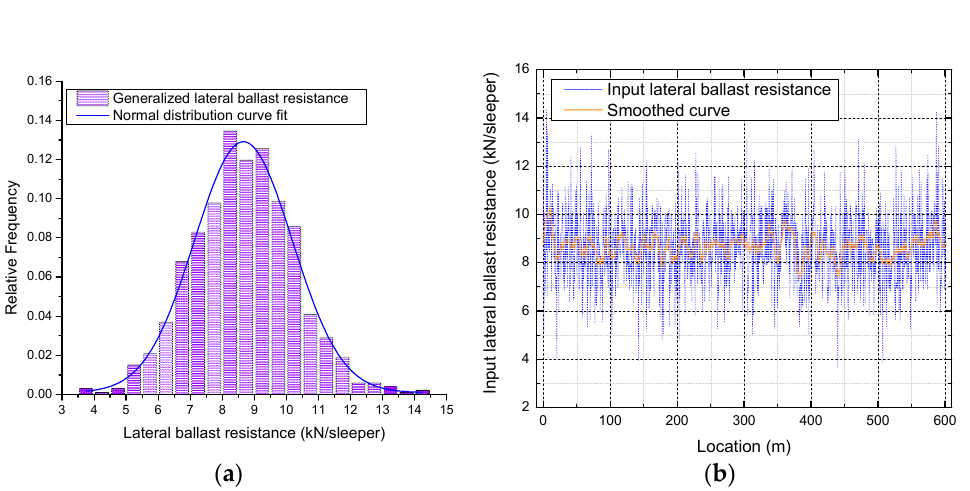
Figure 9. Generated normally distributed lateral ballast resistance. ( a ) Histogram of generated normally distributed lateral ballast resistance; ( b ) Randomly distributed lateral ballast resistance along the CWR